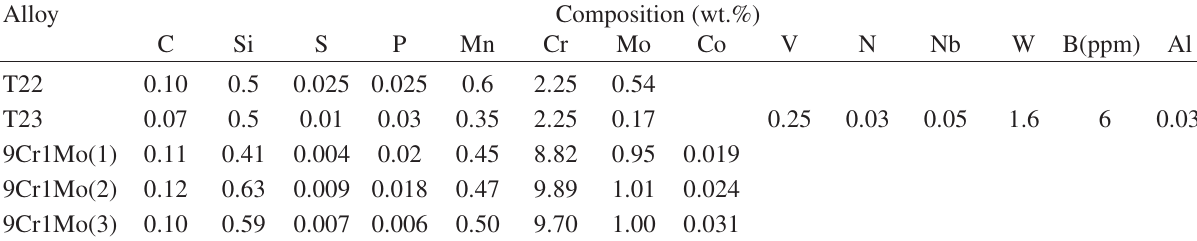
Table 1. Alloy Composition. Alloy Composition (wt.%)